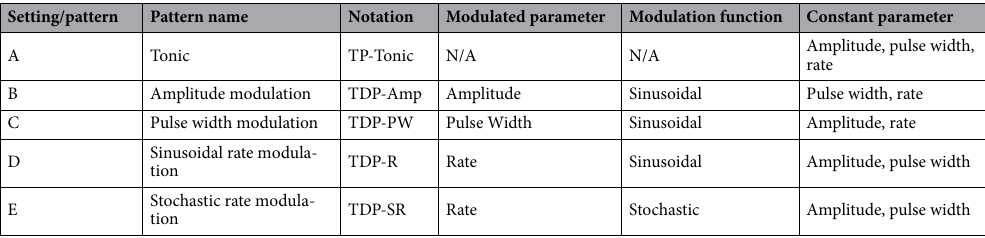
Table 1. List of SCS patterns and their constant and modulated